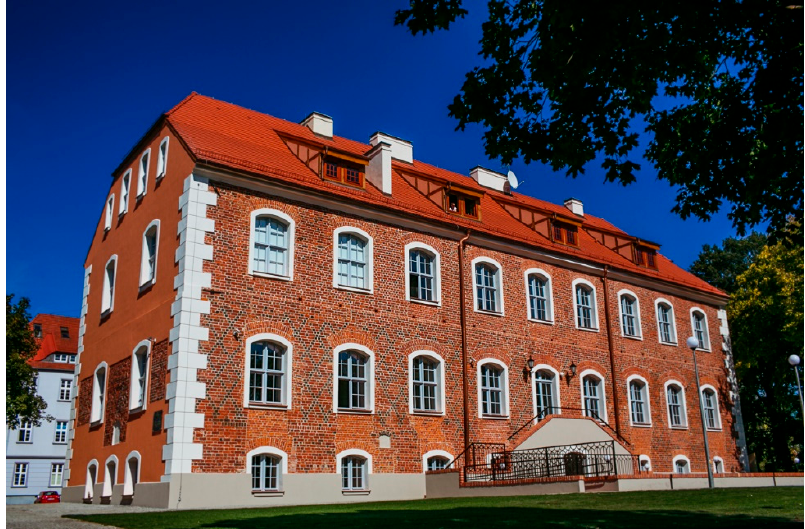
Figure 13. The Pomeranian Dukes’ Castle in Szczecinek, source: Wikimedia Commons.